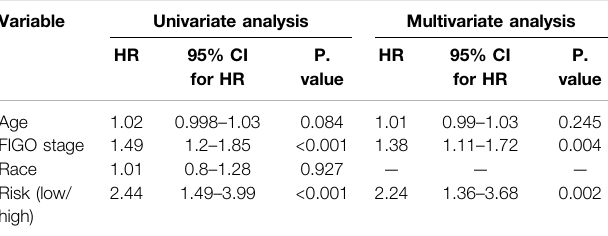
TABLE 3 | Univariable and multivariable Cox regression analyses of clinical characteristics. Variable Univariate analysis Multivariate